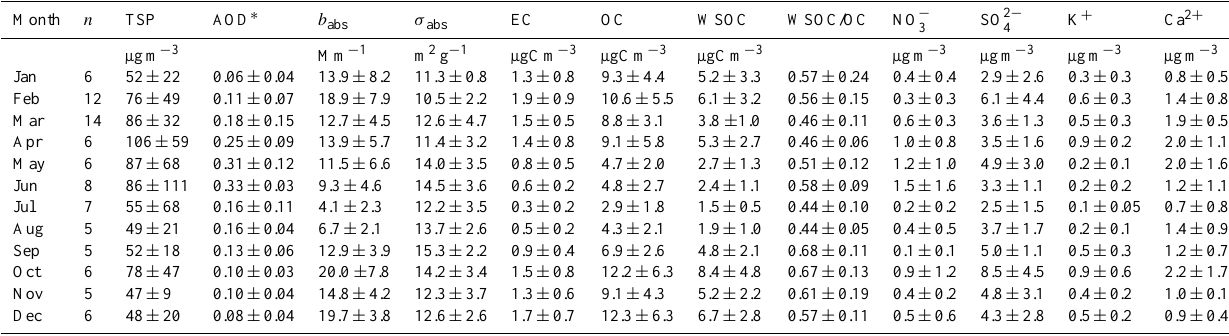
Fig. 3. Temporal variability in the abundances of (a) total suspended particulate (TSP) matter, (b) carbonate carbon (CC), (c) Ca 2 + , (d) OC, (e) EC, (f) WSOC, (g) K + (h) NO − and (i) SO 2 − during the sampling period. The light blue and cyan shaded areas represent winter and 3 4 premonsoon, respectively. The dashed-line (red) separates the monsoon and post-monsoon. Table 1. The monthly average concentrations ( ± 1 σ) of chemical constituents and optical parameters in aerosols at Manora Peak under ambient conditions during February 2005–July 2008. The concentrations in standard conditions can be obtained by multiplying the data in table by a factor of